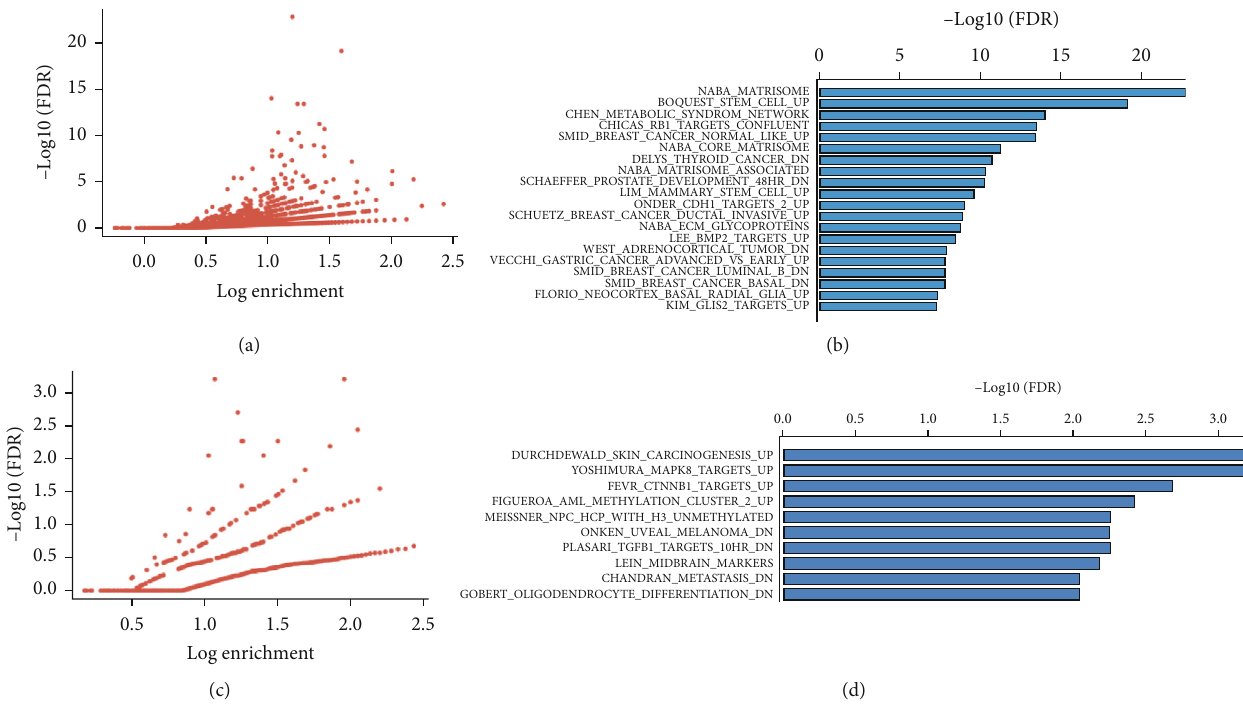
Figure 4: Gene set enrichment analysis of the DEGs identi fi ed from CON/CP and CONR/CPR. Distribution of GSEA enrichment FDR versus enrichment p value, both with log scale for the (a) 132 common genes between CP and CPR and the (c) 34 unique genes in CPR. (b) The top 20 gene sets enriched in the 132 common genes and (d) the top 10 gene sets enriched in the 34 unique genes,